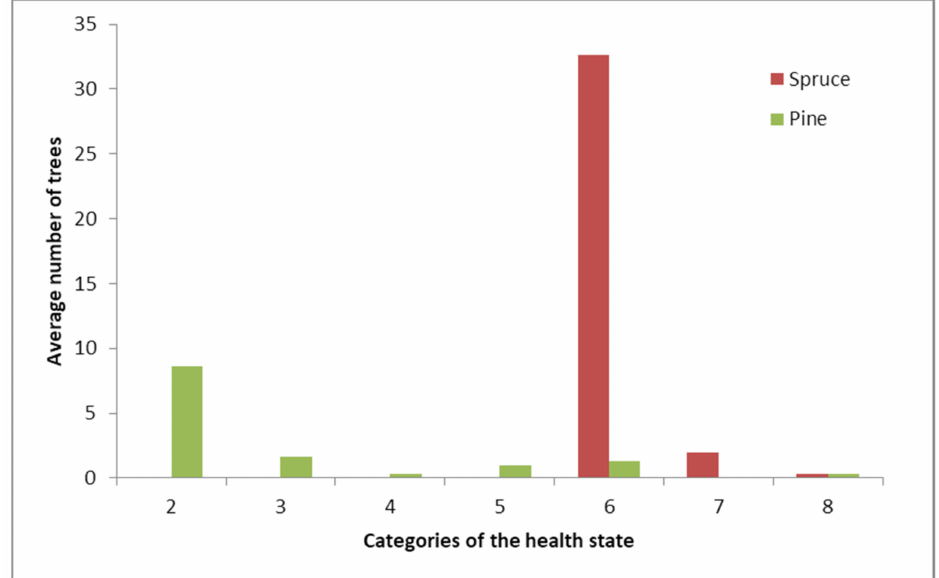
Figure 5. Distribution of spruce and pine by health categories. 2—weakened, 3—heavily